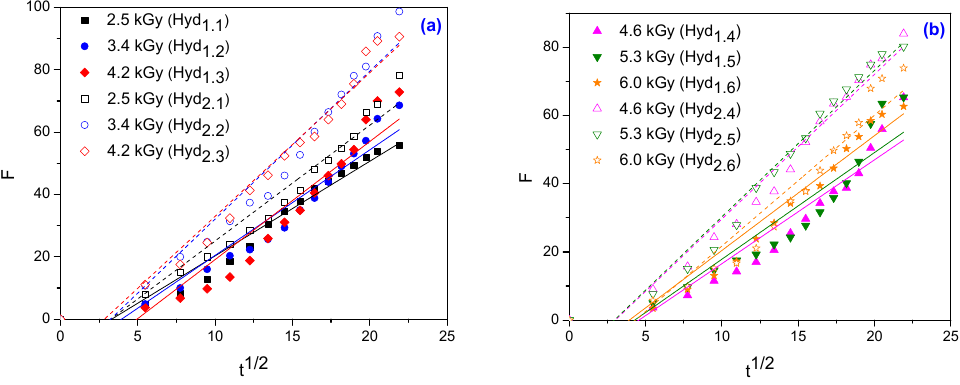
Figure 7. The plots of ln F versus ln t for hydrogels obtained at: ( a ) 2.5 kGy, 3.4 kGy and 4.2 kGy; ( b ) 4.6 kGy, 5.3 kGy and 6.0 kGy.